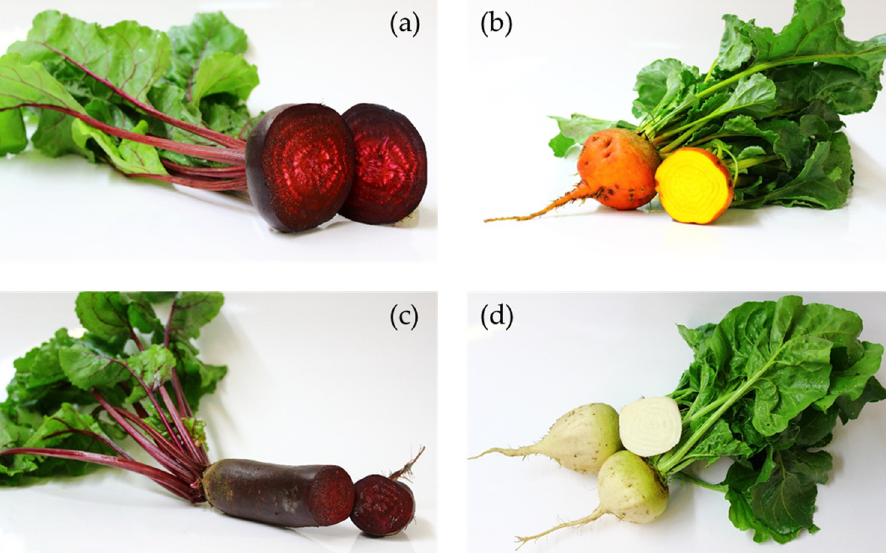
Figure 2. Presentation of four beetroot genotypes according to the beet shape and color ( a ) genotype Ronjana (red and round beet), ( b ) genotype Burpees Golden (yellow and round beet), ( c ) genotype Carillon RZ (red and cylindrical-shaped beet), and ( d ) genotype Sniezna Kula (white and round beet). Pictures are taken by Khadijeh Yasaminshirazi.